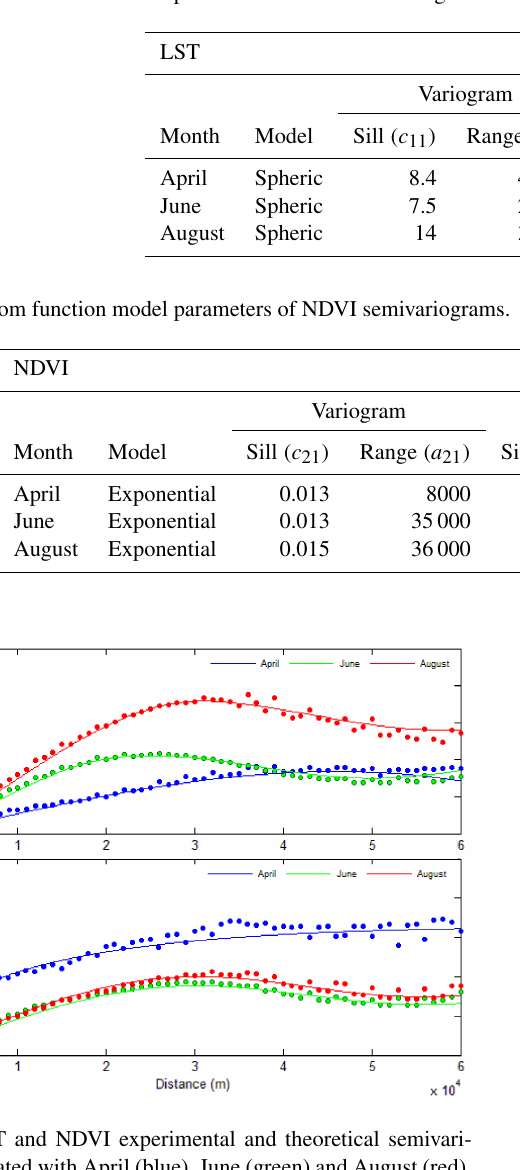
Table 1. Random function model parameters of LST semivariograms.